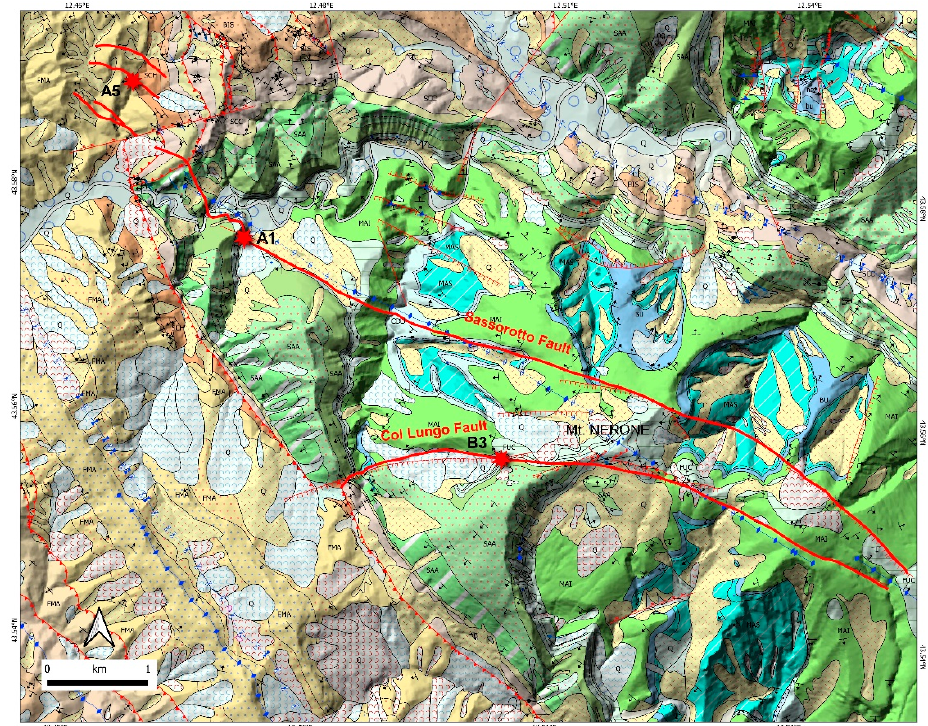
Figure 2. Simplified geological map of the study area from a geological map of the Marche region at a scale of 1:10,000. The thick red lines are the fault traces mapped in this study. A1, A5, and B3 are the observation sites reported in this paper. Geological units: MAS, Calcare Massiccio Formation; BU, Bugarone Group; COI, Corniola Formation; RSA, Rosso Ammonitico Formation; POD, Posidonia Formation; CDU, Calcari diasprini; MAI, Maiolica Formation; FUC, Fucoidi Marls Formation; SBI, Scaglia Bianca Formation; SAA, Scaglia Rossa Formation; VAS, Scaglia Variegata Formation; SCC, Scaglia Cinerea Formation; BIS, Bisciaro Formation; SCH, Schlier Formation; FMA, Marnoso Arenacea Formation; Q, Quaternary